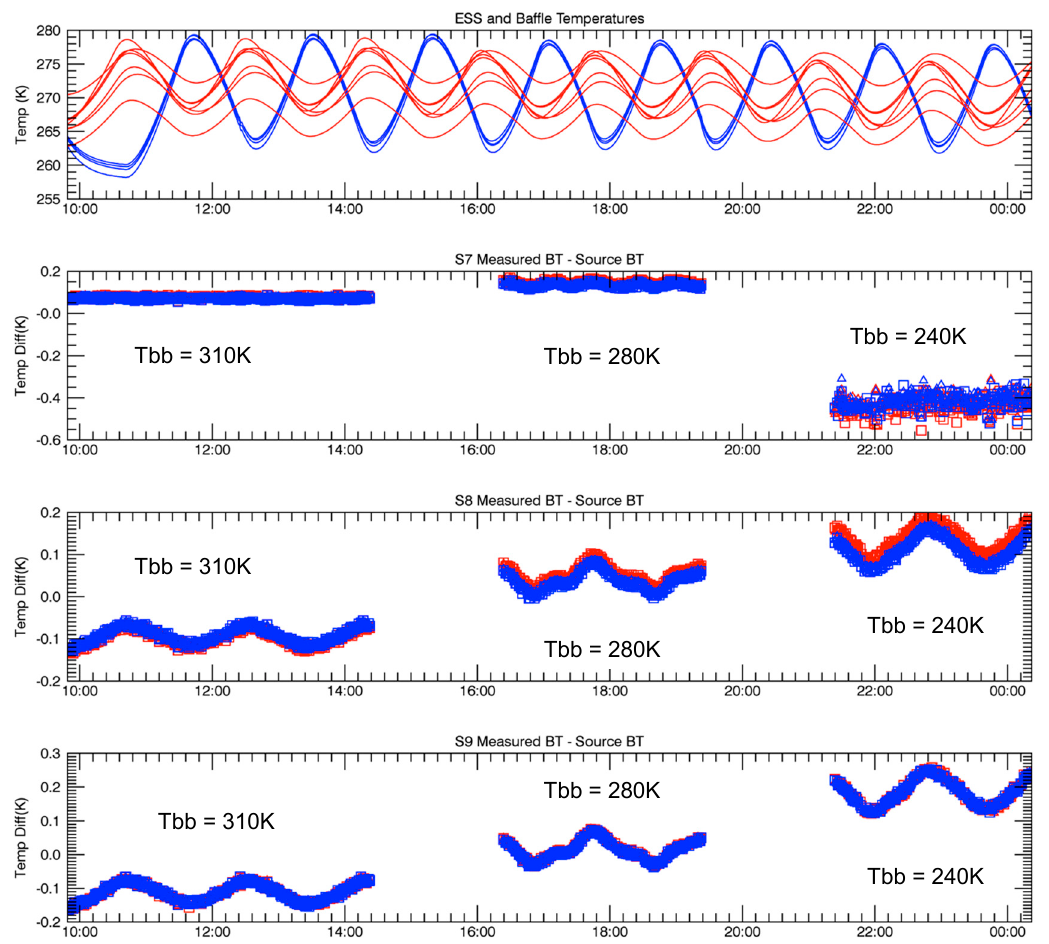
Figure 12. SLSTR-A Orbital simulation results showing the differences between the measured and actual source brightness temperatures. ☐ = Detector 1, Integrator 1; ☐ = Detector 1, Integrator 2; Δ = Detector 2, Integrator 1; Δ = Detector 2, Integrator 1. Error bars are not shown for clarity.